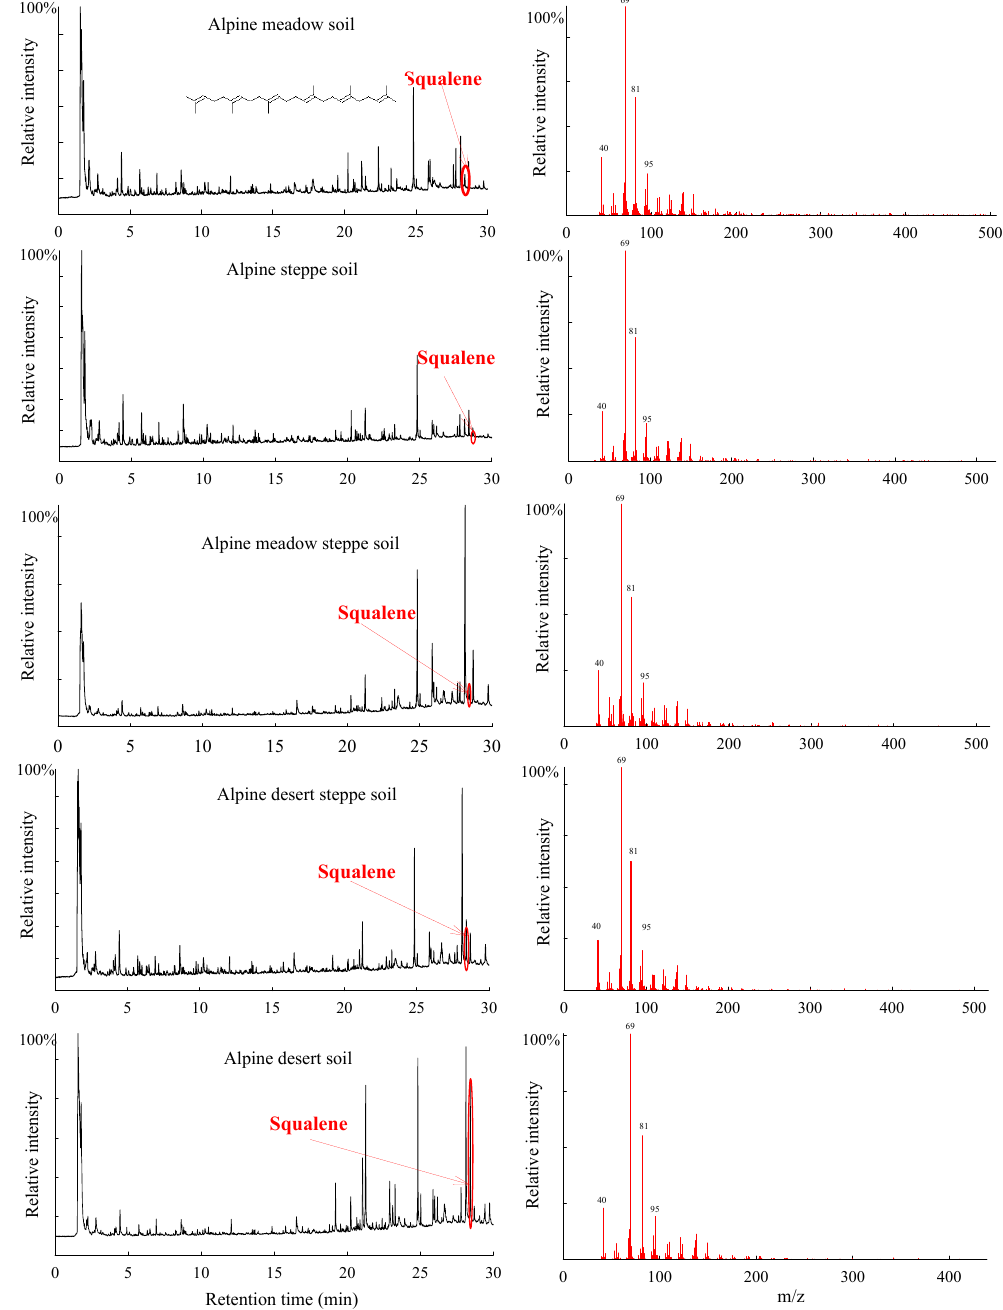
Figure 1. The squalene chromatograms ( left ) and mass spectrums ( right ) obtained from alpine grassland soils by pyrolysis gas chromatography–mass spectrometry (Py-GC/MS) in the Tibetan Plateau. m/z: mass-to-charge ratio.